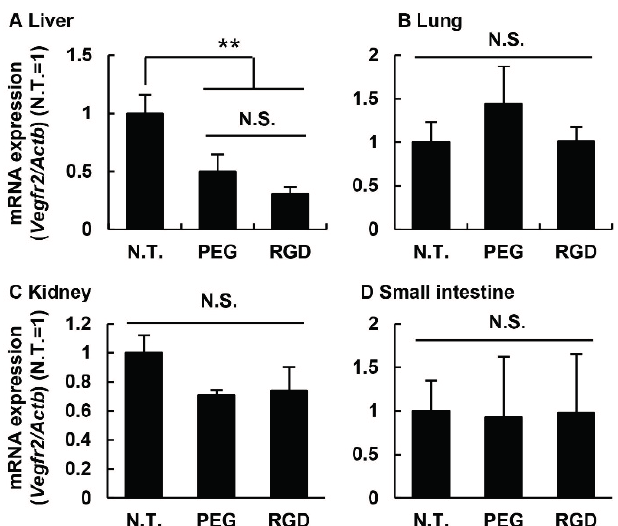
Figure 6. Gene silencing in off-target organs. Vegfr2 expression levels in the liver, lung, kidney, and small intestine were determined by qRT-PCR 24 h after ICR mice were treated with 3.0 mg/kg of PEG- or RGD-MEND. Data represent mean ± S.D. ( n = 3). ** , p < 0.01 (one-way ANOVA followed by Bonferroni